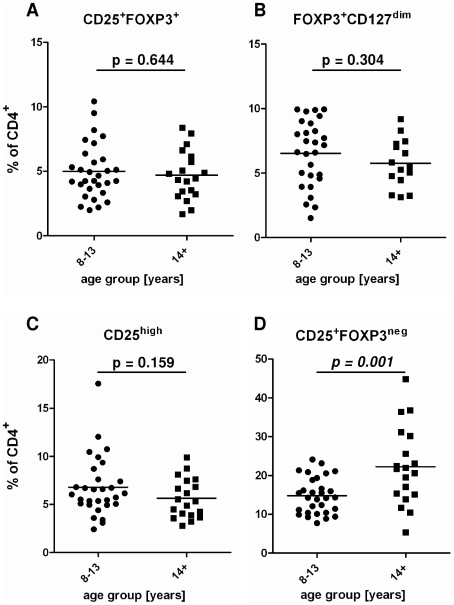
The proportion of Treg does not differ between age group regardless of markers employed.Dot plots show the fraction of Treg identified by a combination of different markers: (A) CD25+FOXP3+ cells, (B) FOXP3+CD127dim cells and (C) CD25high cells as percentage of CD4+ T cells in the different age groups. In (D) percentages of CD25+FOXP3neg Tact are presented.